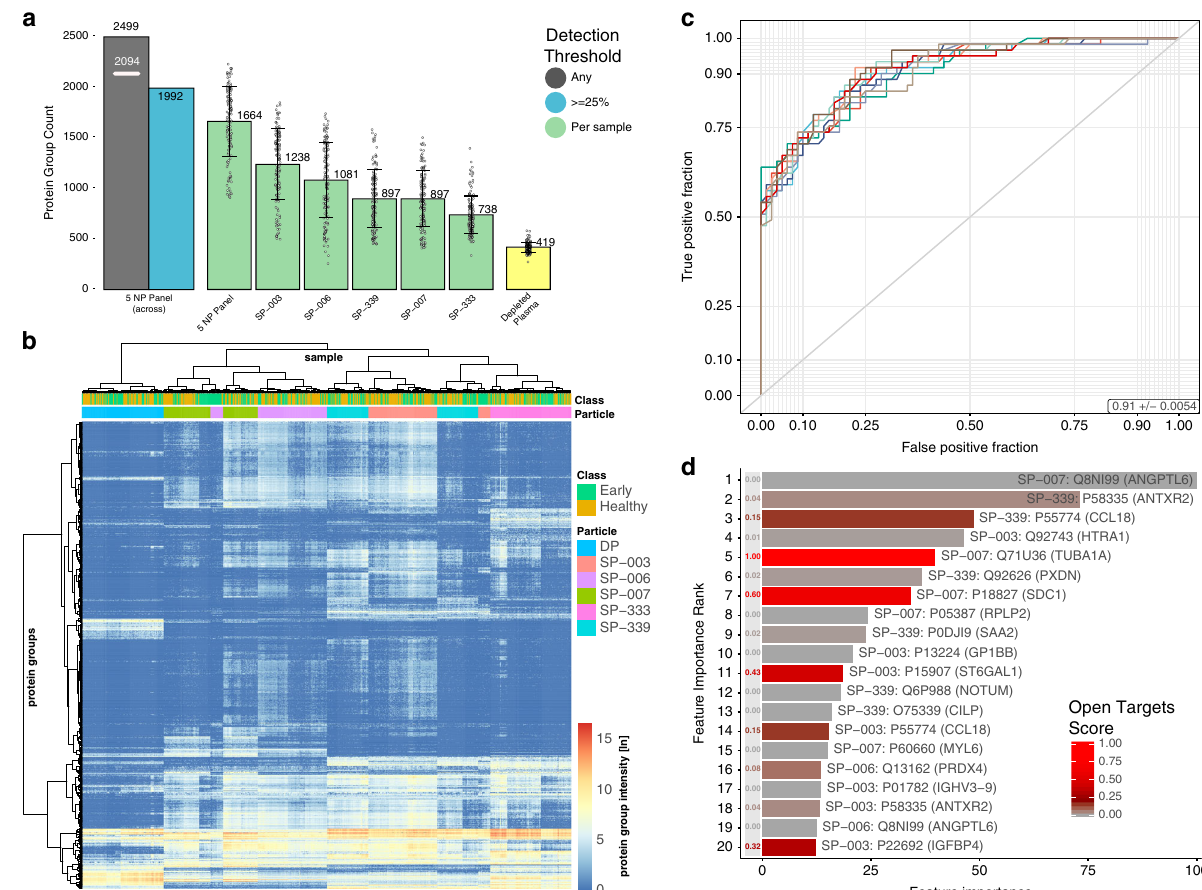
Fig. 5 Classi fi cation of early NSCLC vs healthy using fi ve NPs. a Protein group counts by NP and depleted plasma ( fi ltered for 1% peptide and protein FDR). The green bars show the mean number of proteins in the cohort of 141 subjects found with the fi ve NPs. The yellow bar shows the mean number of proteins in the cohort of 141 subjects for depleted plasma, the black bar shows the number of proteins across the fi ve NP panel and all 141 subjects. The white line indicates the proteins that were detected with two peptides or more with one or more NP. The blue bar shows number of proteins across the fi ve NP panel that were detected in at least 25% of all 141 subjects. Error bars depict standard deviation of identi fi cations. White circles show number of protein IDs for each biological sample. b Heatmap showing the median normalized intensities (natural logarithm) of protein groups (rows) detected with fi ve NPs (columns) or depleted plasma across 141 subjects (early NSCLC and healthy). Protein groups were fi ltered for 1% peptide and protein FDR and detection in at least 10% of the samples. Missing values were set to 0 (dark blue). Hierarchical clustering was performed in R using the ward.d2 method. c Receiver operating characteristic (ROC) curves quantifying the classi fi cation performance of healthy vs. early-stage NSCLC patients. Each colored curve represents one of the 10 repeats of the 10-fold cross validation where the performance was assessed on the hold-out test splits. The ROC average area under the curve (AUC) for across the 10 repeats is 0.91. d Top 20 most important features to classify healthy vs early NSCLC, with the color gradient showing the associated Open Targets Score for lung carcinoma targets. Source data are provided as a Source Data fi